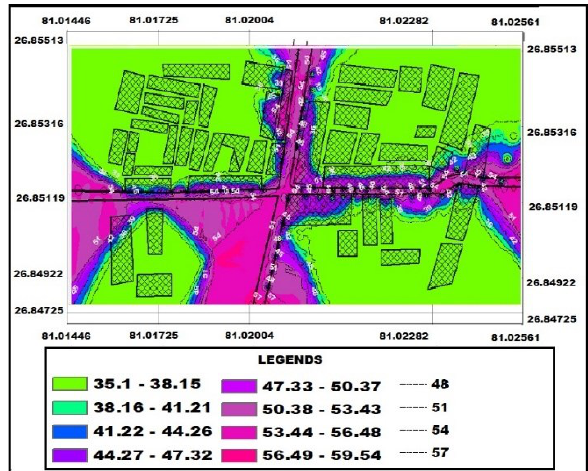
Figure 5. Noise level map of Haniman crossing for unorganized road for evening time.